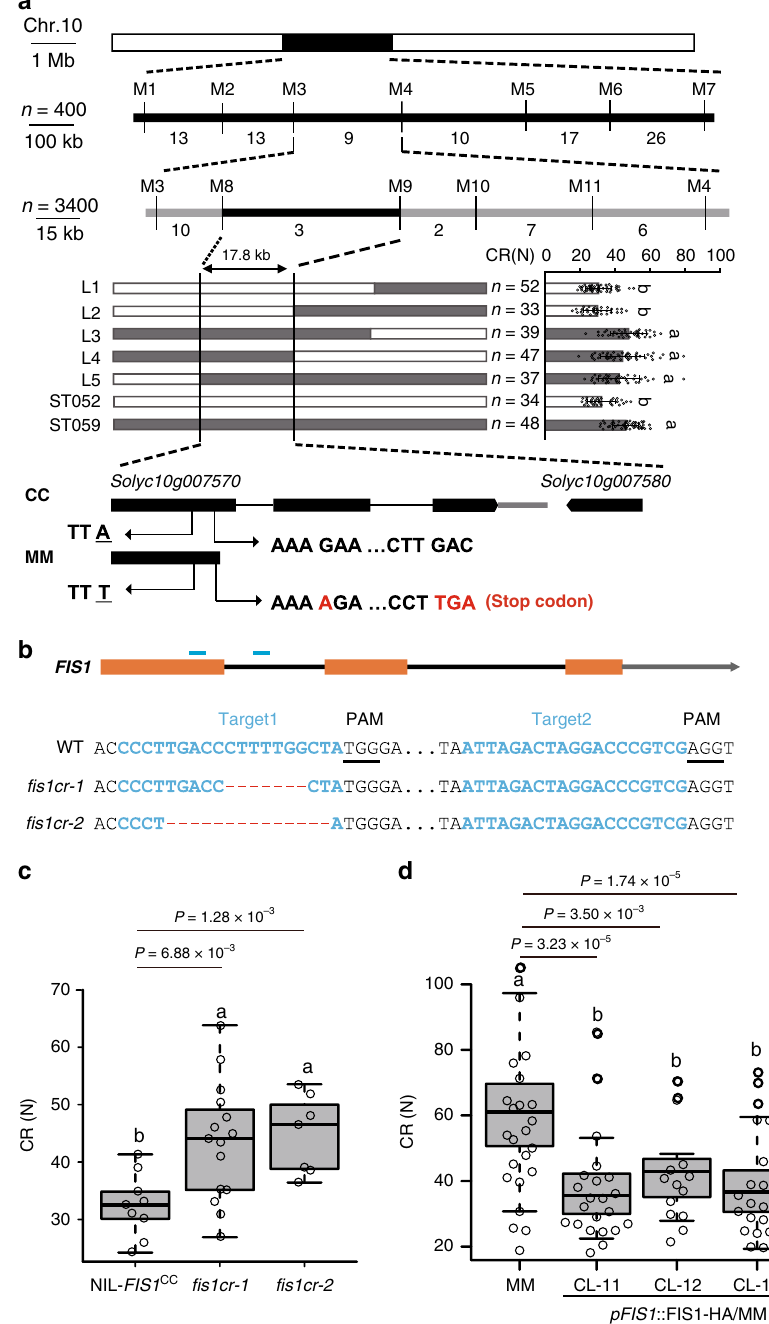
Fig. 2 FIS1 is responsible for fruit fi rmness formation in tomato. a Fine mapping of qFIS1 . Top panel: positional cloning narrowed qFIS1 to the DNA segment between markers M8 and M9. The numbers below the bars indicate the number of recombinants. n = plant number. Middle panel: high-resolution mapping of qFIS1 (left) and CR of recombinant progeny (right). Error bars, mean ± SD. n = fruit number. Different letters indicate signi fi cant differences according to the Tukey – Kramer test ( P < 0.05). P = 3.58 × 10 − 18 (L1 and ST059), P = 9.91 × 10 − 15 (L2 and ST059), P = 0.55 (L3 and ST059), P = 0.28 (L4 and ST059), P = 0.07 (L5 and ST059), P = 1.65 × 10 − 12 (ST052 and ST059). Bottom panel, genomic diagram showing the two candidate genes. In addition to one SNP, a single nucleotide insertion in the 1st exon of Solyc10g007570 in MM causes early termination. b FIS1 mutations generated by CRISPR/Cas9 using two single-guide RNAs. Blue lines indicate the target sites of the guide RNAs. Black lines indicate the protospacer-adjacent motif (PAM). The sequences of the two fi s1 mutants in NIL- FIS1 CC are shown. c Box plots of red ripe fruit CR for fi s1cr-1/2 mutants and NIL- FIS1 CC . n = 9, 15, and 17 fruits. Box edges represent the 0.25 and 0.75 quantiles, and the bold lines indicate median values. Whiskers indicate 1.5 times the interquartile range. Different letters indicate signi fi cant differences according to the Tukey – Kramer test ( P < 0.05). d Box plots of red ripe fruit CR for MM and three transgenic complementation lines (CL-11, CL-12, CL-17). n = 23, 22, 13, and 27 fruits. Box edges represent the 0.25 and 0.75 quantiles and the bold lines indicate median values. Whiskers indicate 1.5 times the interquartile range. Different letters indicate signi fi cant differences according to the Tukey – Kramer test ( P <